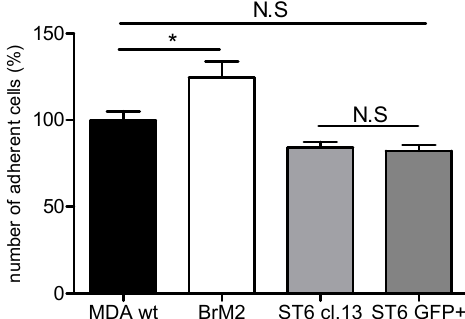
Figure 5. Adhesion of MDA-MB-231 wt, BrM2, Clone #13, and GFP+ breast cancer cell populations on a mouse blood-brain barrier (BBB) model. The number of adherent MDA-MB-231 wt cells was set up to 100% and equal to 286 cells. Results are the mean in triplicate, and representative of two independent experiments. N.S: not significant; * p < 0.1.